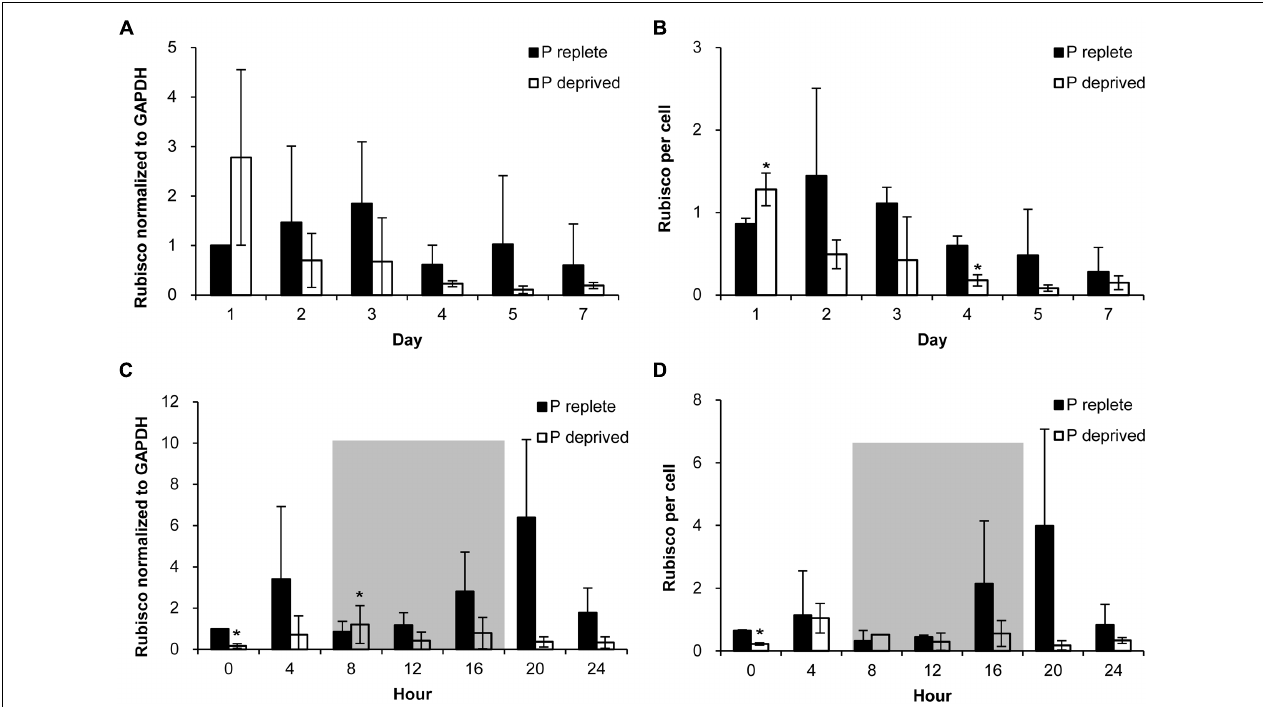
FIGURE 6 | Abundance of Rubisco in A. carterae in the P-replete group and P-deprived group normalized to GAPDH and to per cell measured daily over the 7-day observation period (A,B) and every 4 h over a 24-h diel cycle (C,D). Gray shading indicates dark period. Shown are means ± standard deviations (error bars) from the triplicated cultures. Asterisks represent that significant differences between P-replete and P-deprived conditions were detected ( p <